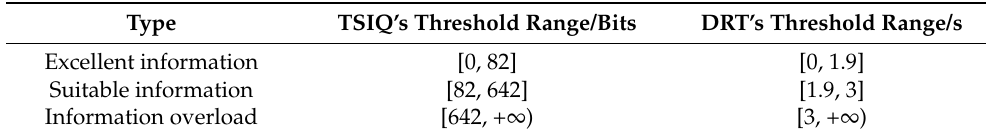
Table 5. The reasonable range of